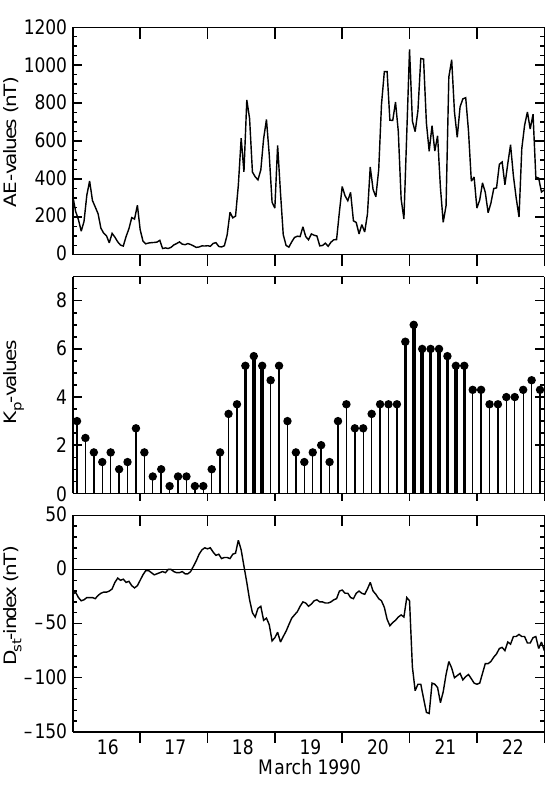
Calculated Observed – SD +